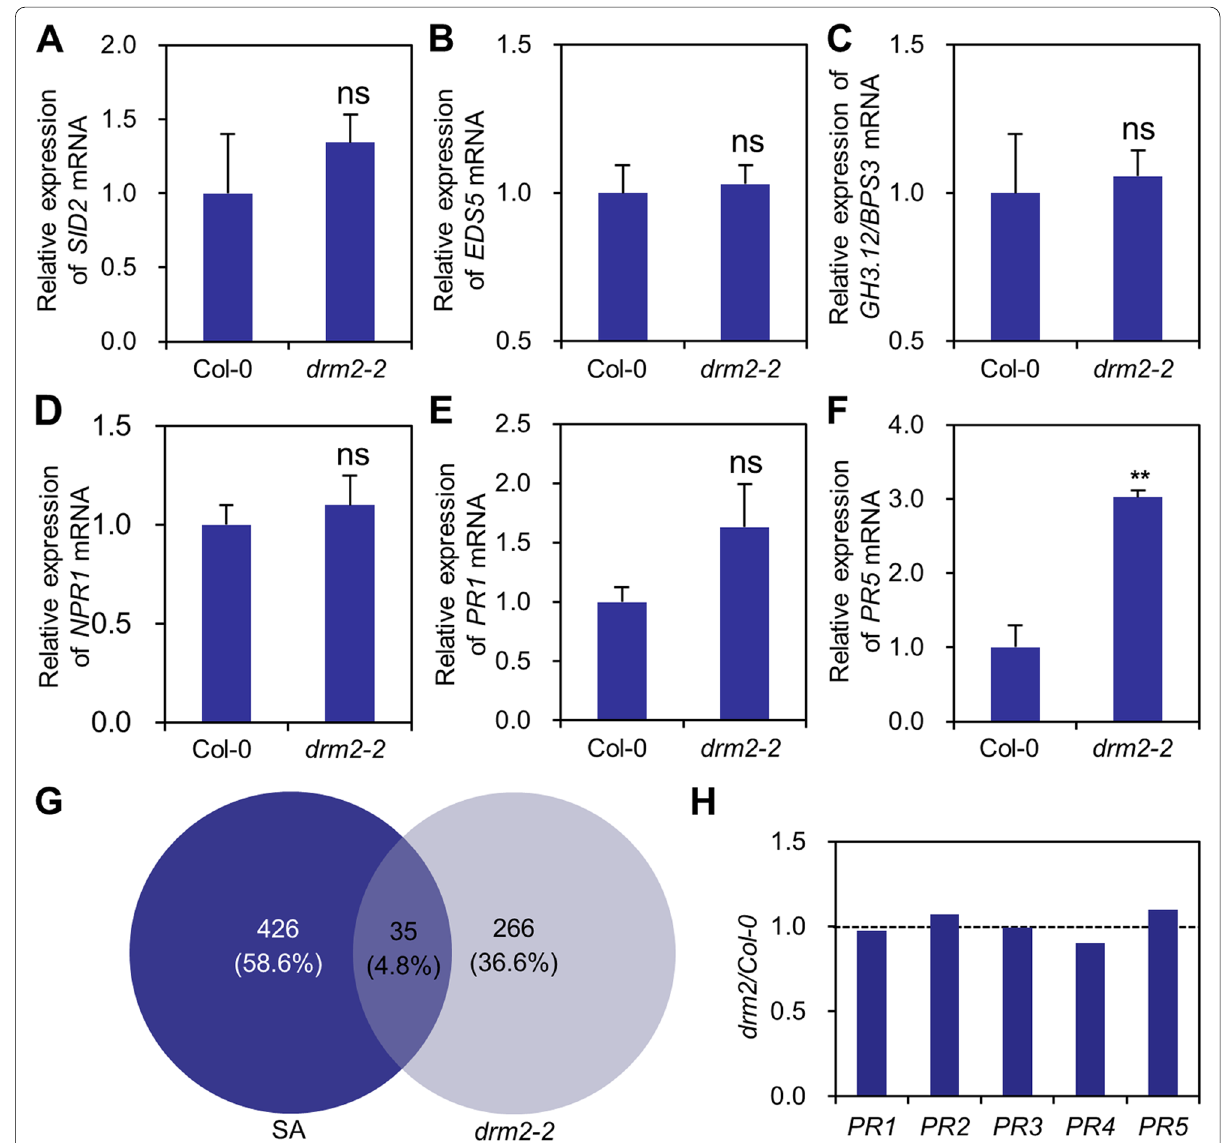
Fig. 4 RT-qPCR and transcriptome analysis of the expression of salicylic acid-related genes. A‑F The expression of SID2 ( A ), EDS5 ( B ), GH3.12/ PBS3 ( C ), NPR1 ( D ), PR1 ( E ), and PR3 ( F ) in wild-type and drm2–2 mutant, respectively. ACTIN II was used as the internal control. Transcript level in mock plants was normalized to 1. Data are mean s.d. ( n 5). G Venn diagram showing numbers of DEGs between mock- and SA-treated ± = wild-type Arabidopsis (dark blue) and between wild-type Arabidopsis and drm2 (light blue). H Abundant of PR1-5 transcript in transcriptome